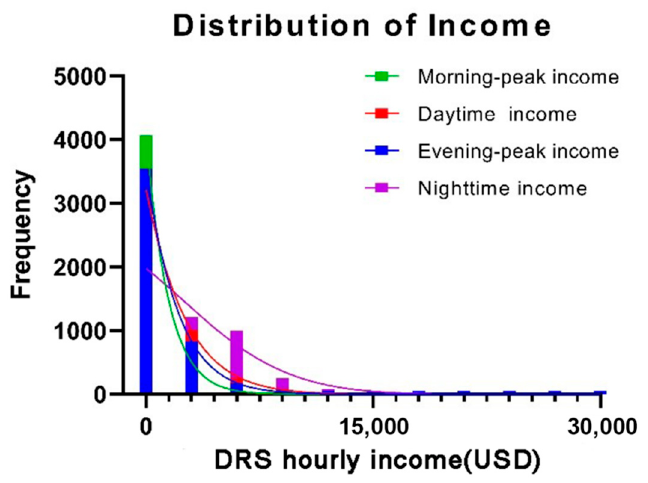
Figure 9. Distribution histogram for DRS income at different time periods.